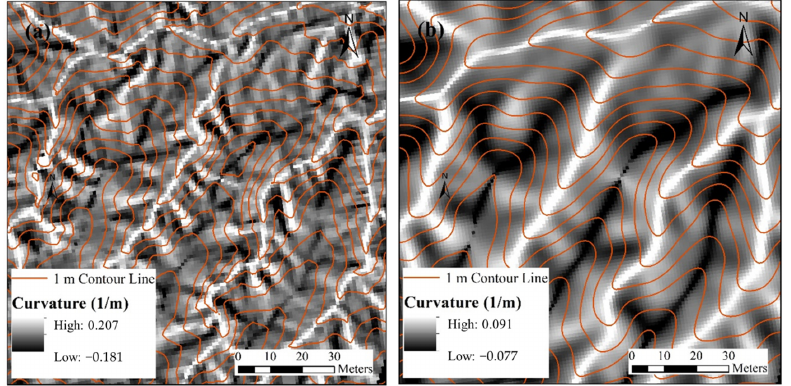
Figure 3. One-meter contour lines and the curvature grid for ( a ) the original DEM and ( b ) the smoothed DEM after applying Perona-Malik filter with the time of forward diffusion set to 50 ( 𝑇 (cid:3007) (cid:3404) 50 ) on the Isleta Drain watershed located in New Mexico.